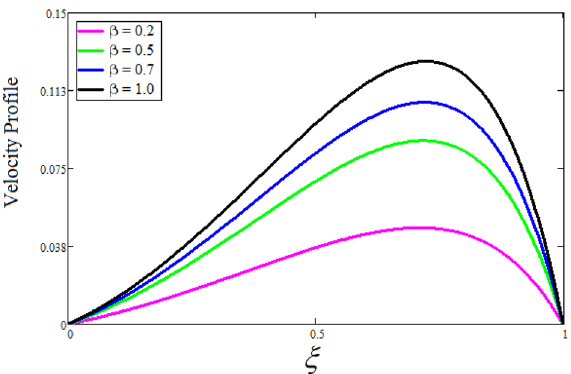
Figure 10. The consequence of β on velocity distribution. Where R ζ = 2, φ = 0.04, δ = γ = π 3 , M = 5, k = 0.3, Gr = 10, Gm = 20, α = 0.5, t = 1, Sc = 10,